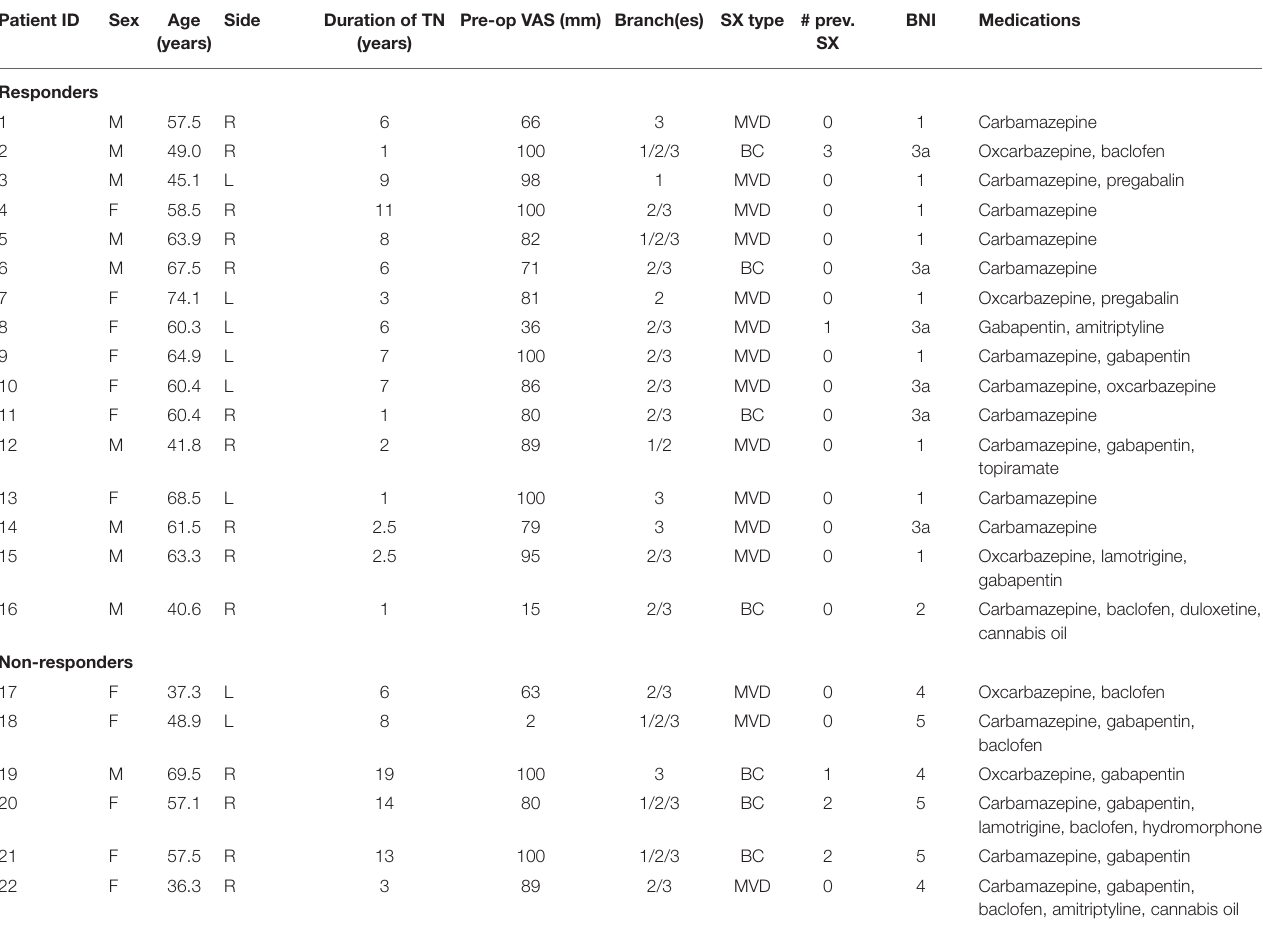
TABLE 2 | Clinical characteristics of TN patients. Patient ID